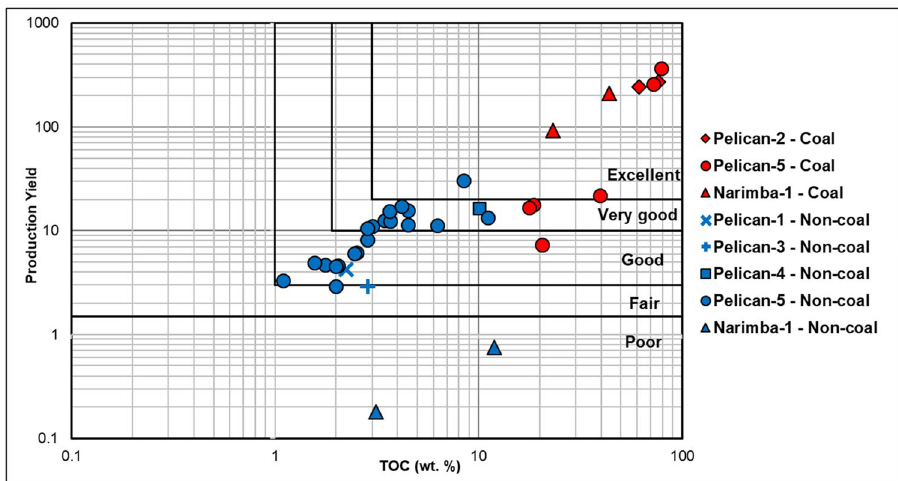
Fig. 5 PY versus TOC cross- plot indicating hydrocarbon generating potential